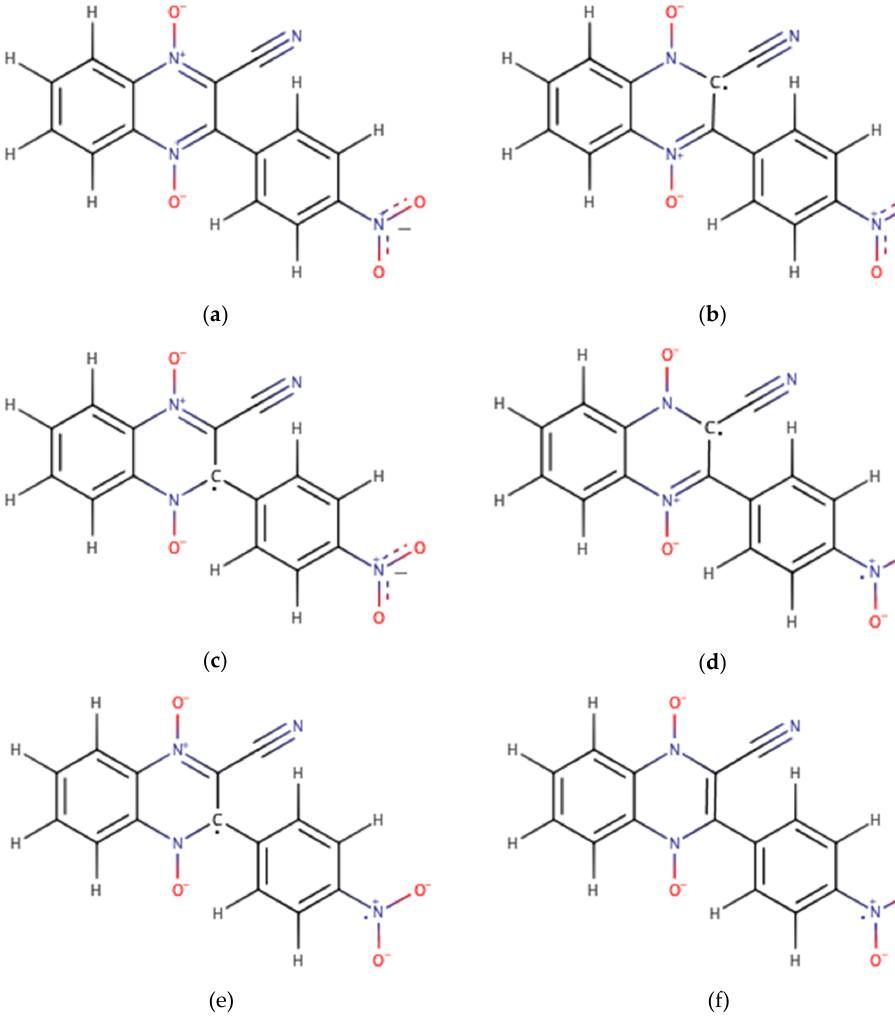
Figure 2. The individual structures for molecule E1: ( a ) the neutral molecule; ( b ) the possible anion product of Wave 1 with the radical on C2; ( c ) the possible anion product of Wave 1 with the radical on C3; ( d ) the possible dianion product of the Nitro Wave with radicals on C2 and on the nitro group; ( e ) the possible dianion product of the Nitro Wave with radicals on C3 and on the nitro group; and ( f ) the trianion product of Wave 2. Chemical structures drawn in MarvinSketch [20].